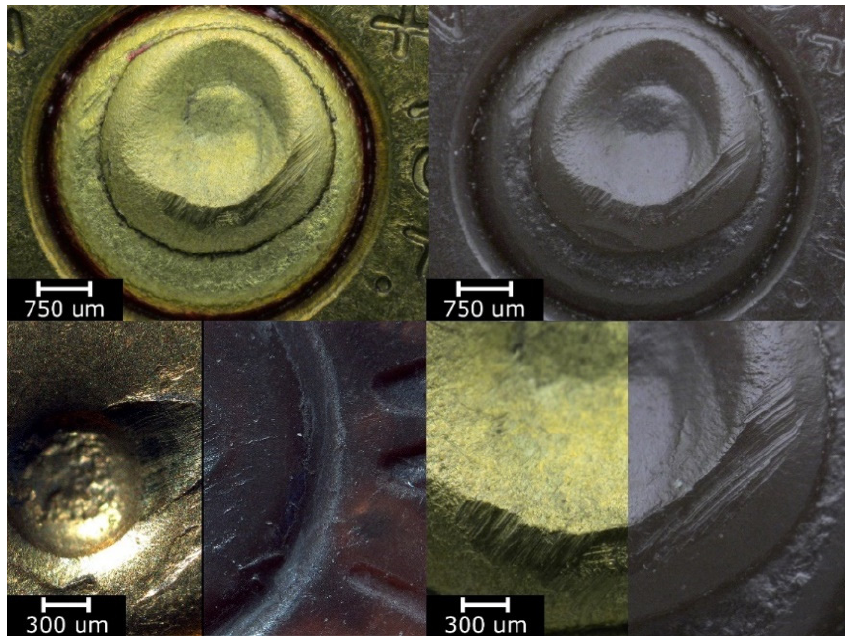
Figure 8. View of the specimens from series 13 (replicas) compared to the original objects. Images of the original objects are on the left, the replicas are on the right. Images were recorded with a comparison microscope.